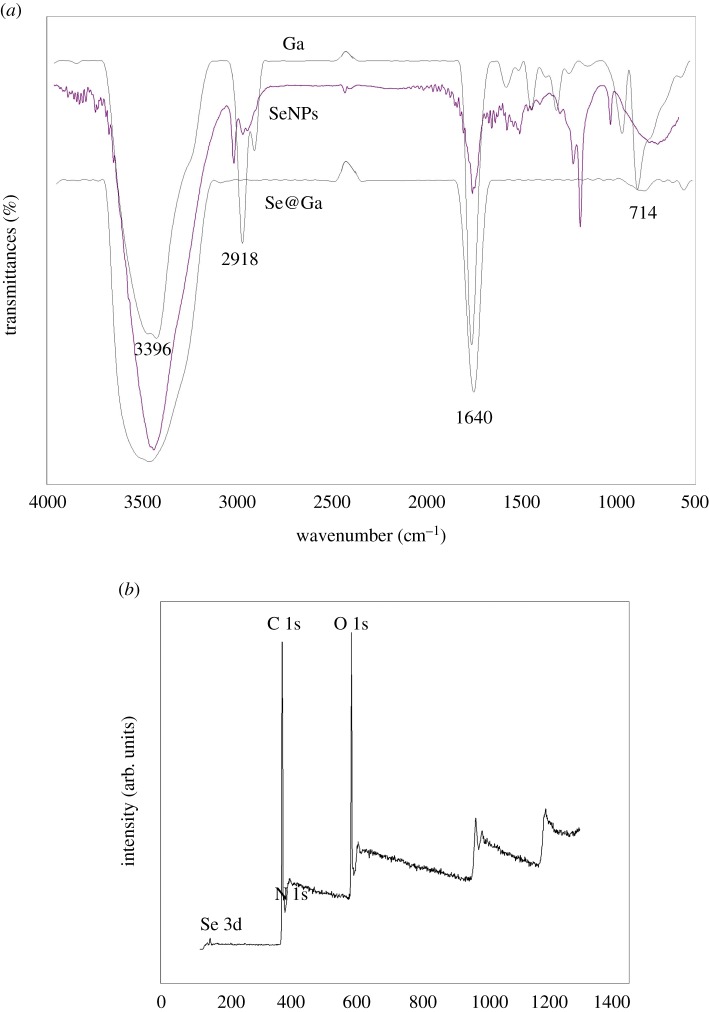
The FT-IR spectra and XPS of Se@Ga. All IR spectra were acquired in the form of KBr plates. (a) FT-IR spectrums. (b) XPS detection.